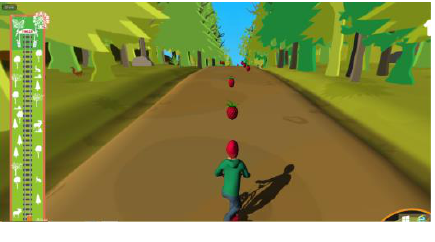
Figure 1. The SportWall game